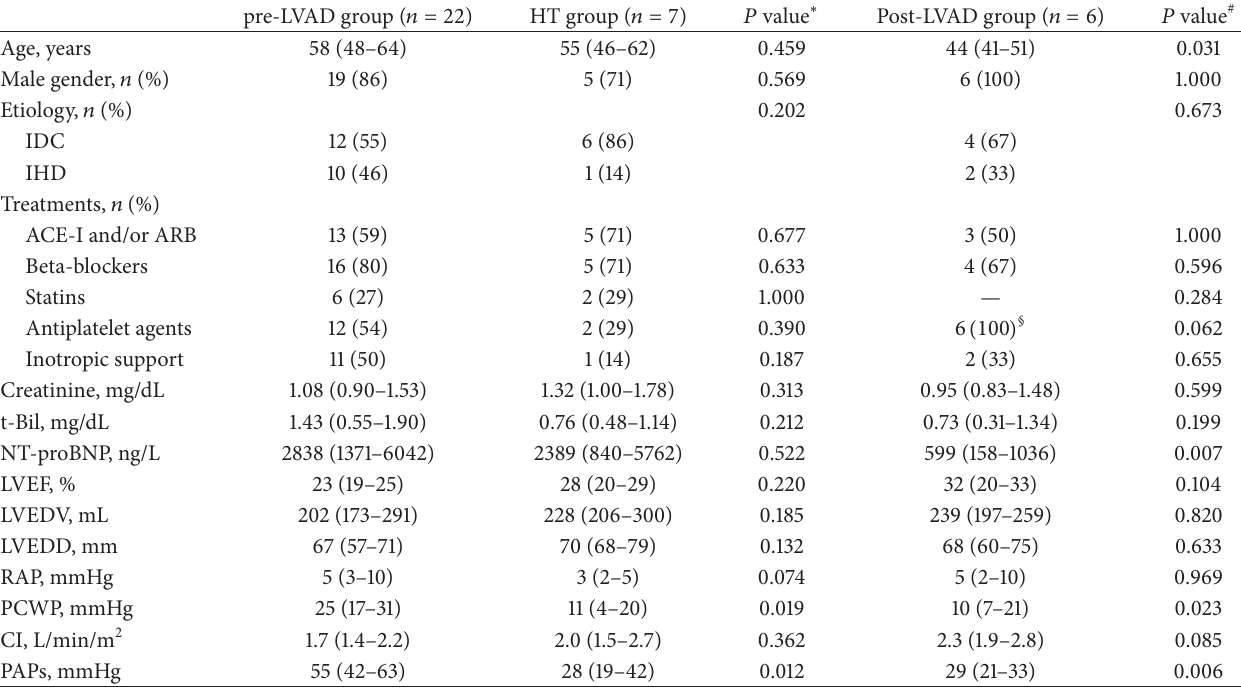
Table 2: Clinical features of ESHF patients according to sample